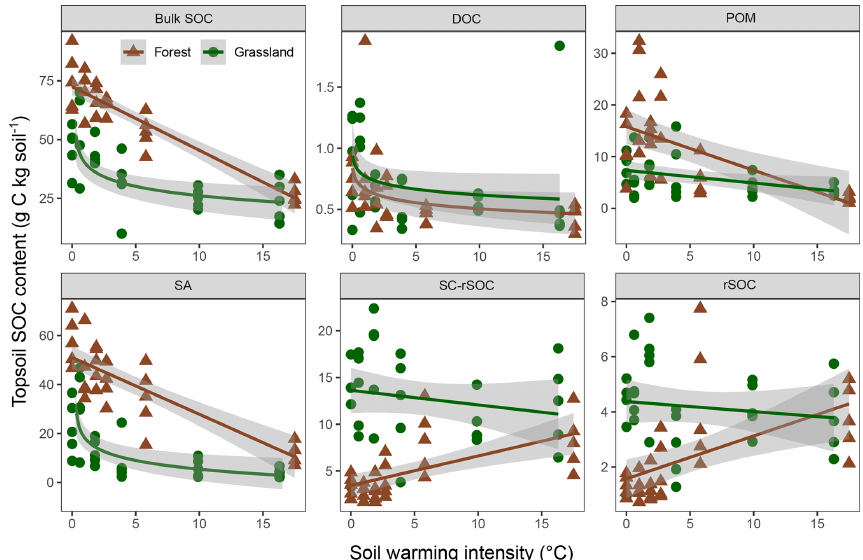
Figure 4. Soil organic carbon (SOC) mass in the bulk soil and fractions of the forest and grassland topsoils (0–10cm) as a function of warm- ing intensity with linear and logarithmic fits and the 95% confidence intervals. Fractions were dissolved organic carbon (DOC), particulate organic matter (POM), SOC in sand and aggregates (SA), non-oxidation-resistant silt- and clay-sized SOC (SC-rSOC), and oxidation- resistant silt- and clay-sized SOC (rSOC).